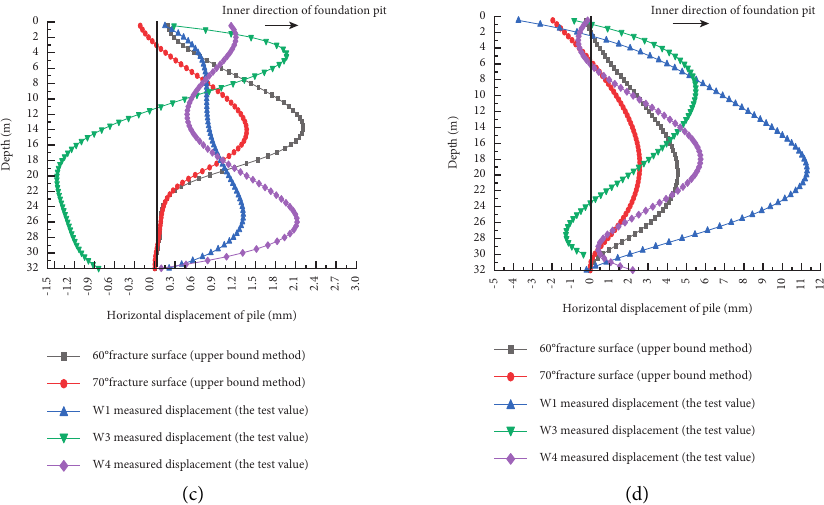
Figure 15: Comparison of the theoretical calculations and actual measurements. (a) Excavation depth of 15m, before installation of the first steel retail pile. (b) Excavation depth of 20m. (c) Excavation depth of 25m, before installation of the second steel retaining pile. (d) Excavation depth of